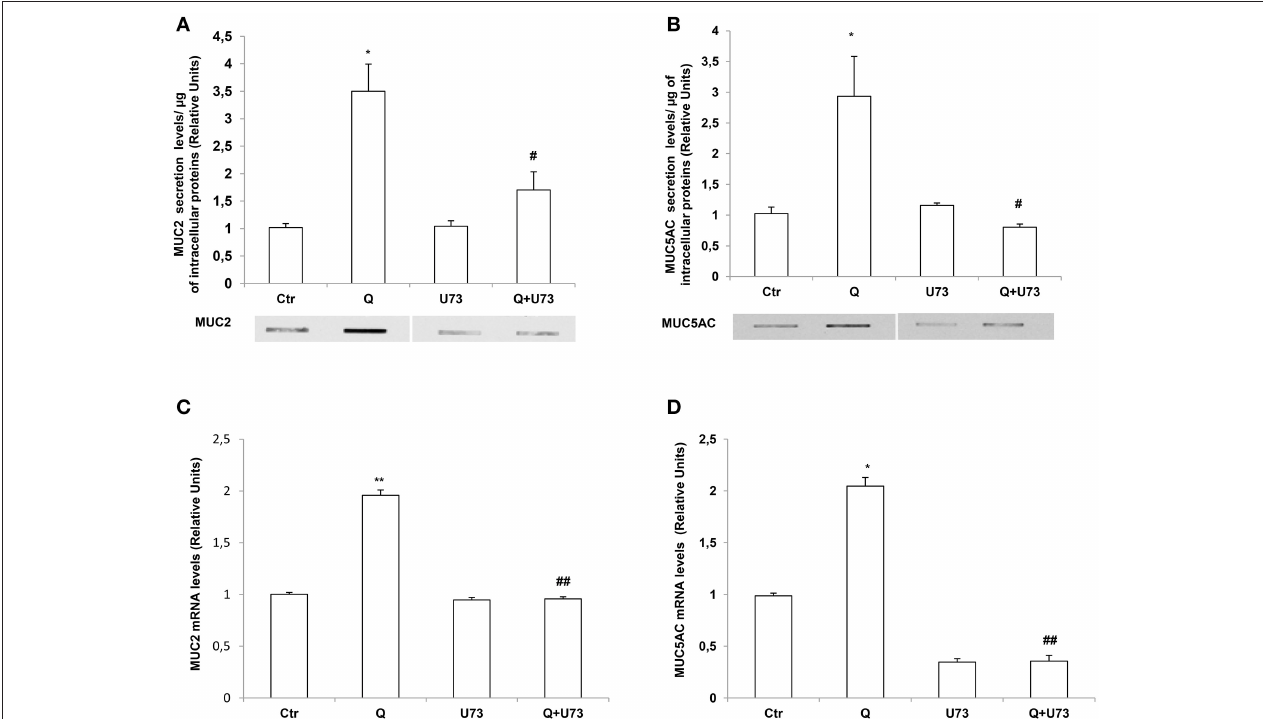
FIGURE 5 | Quercetin induces MUC2 and MUC5AC secretion and mRNA levels through a PLC-dependent pathway. (A,B) Slot-Blot analysis of incubation medium of LS174T cells grown for 24h, in MEM without FBS stimulated with 50 µ M quercetin (Q) in the absence or presence of the PLC inhibitor, U73122. The histogram shows the mean ± SE ( n = 3) of MUC2 (A) and MUC5AC (B) secretion protein levels obtained by densitometric analysis of three independent experiments and normalized for the respective cell protein concentrations. (C,D) Real-time-PCR analysis of MUC2 (C) and MUC5AC (D) m-RNA levels in LS174T cells treated for 24h with 50 µ M quercetin in the absence or presence of U73122, in medium without serum. Expression values were normalized using glucose-6-phosphate-dehydrogenase mRNA (G6PD). The histogram shows the mean ± SE ( n = 3) of mRNA levels of three independent experiments. * p < 0.05 vs. Ctr, ** p < 0.01 vs. Ctr, # p < 0.05 vs. Q, ## p < 0.01 vs.